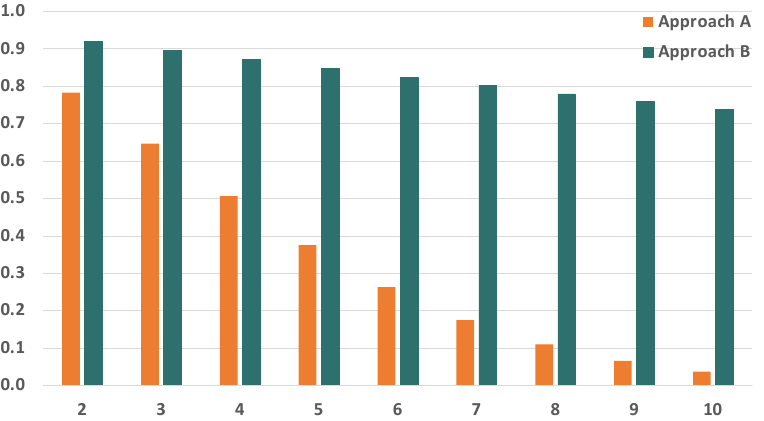
Figure 16. Reliability achievable when varying the number of bridges in a network with a BER of 1 × 10 − 6 . Approach A is represented in orange and approach B in green. The x axis represents the number of bridges, while the y axis represents the